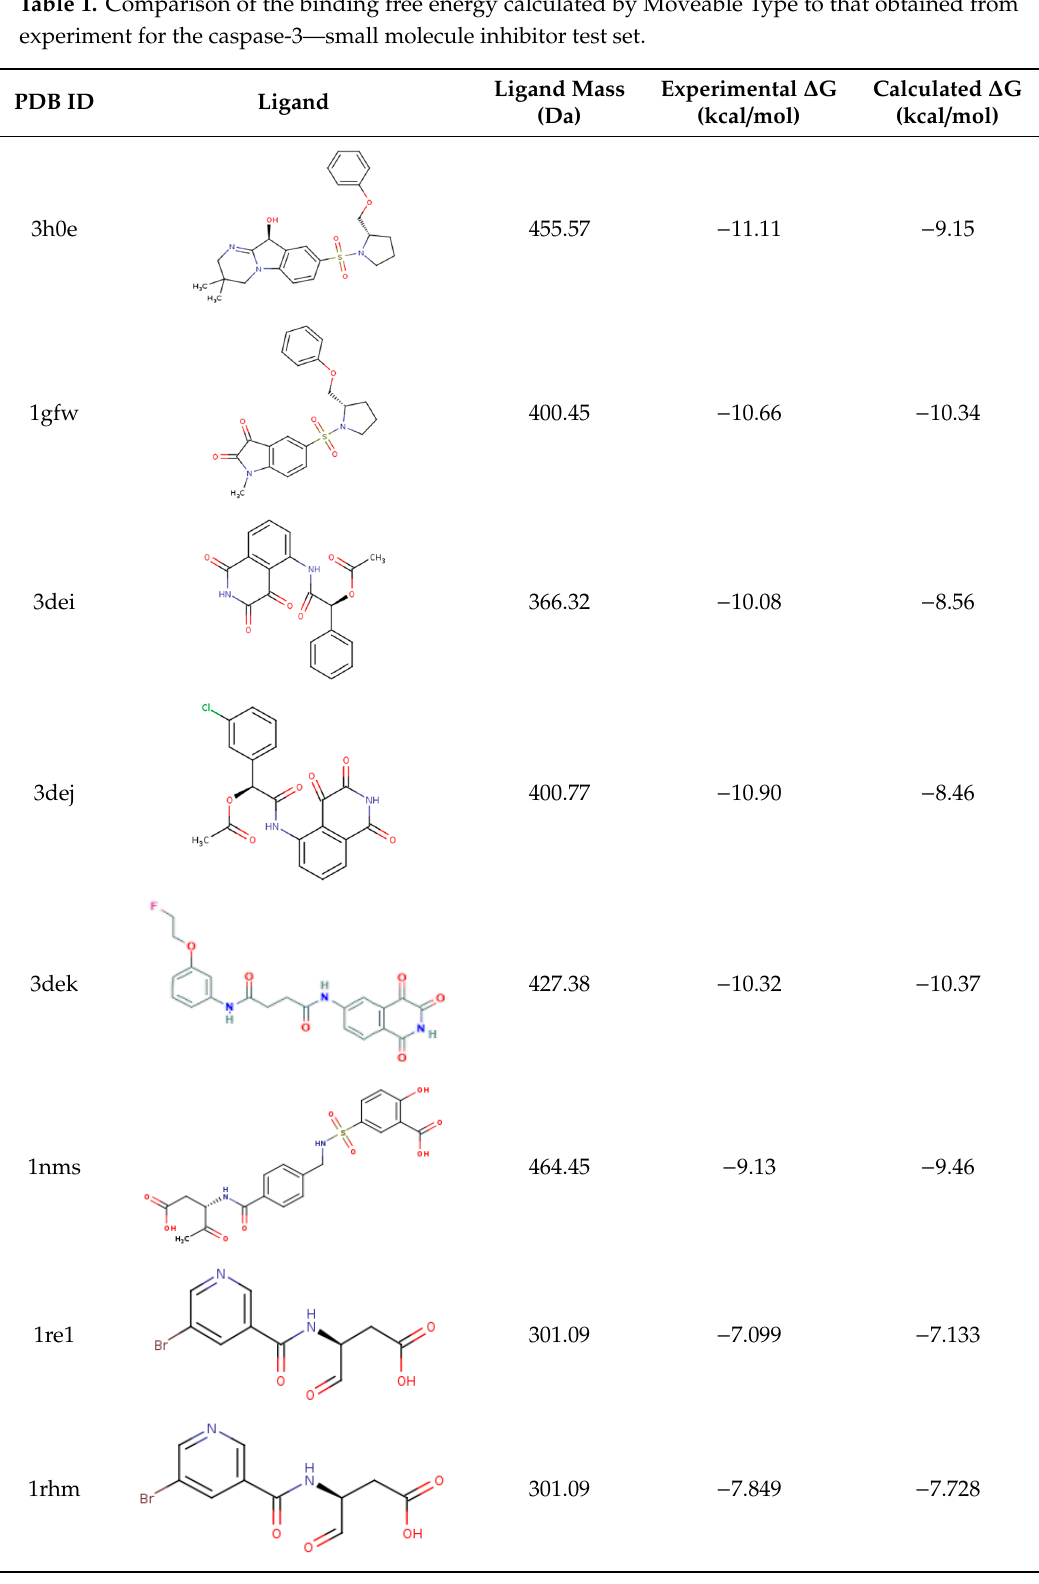
Table 2. Comparison of the binding free energy calculated by Moveable Type to that obtained from experiment for the caspase-3—peptidomimetic molecule inhibitor test set. PDB ID